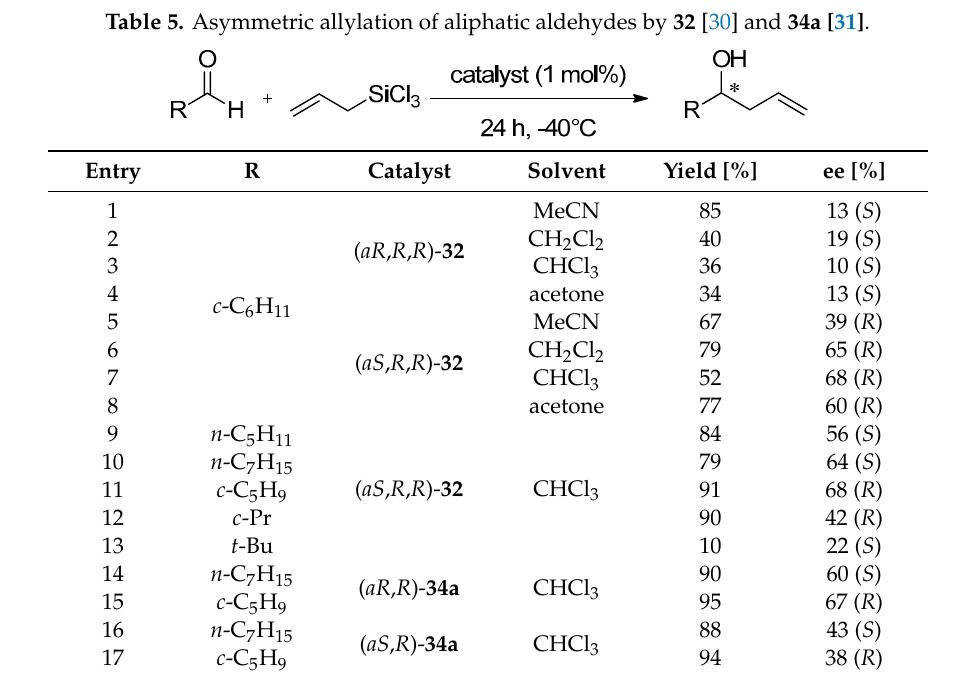
Table 5. Asymmetric allylation of aliphatic aldehydes by 32 [30] and 34a [31].